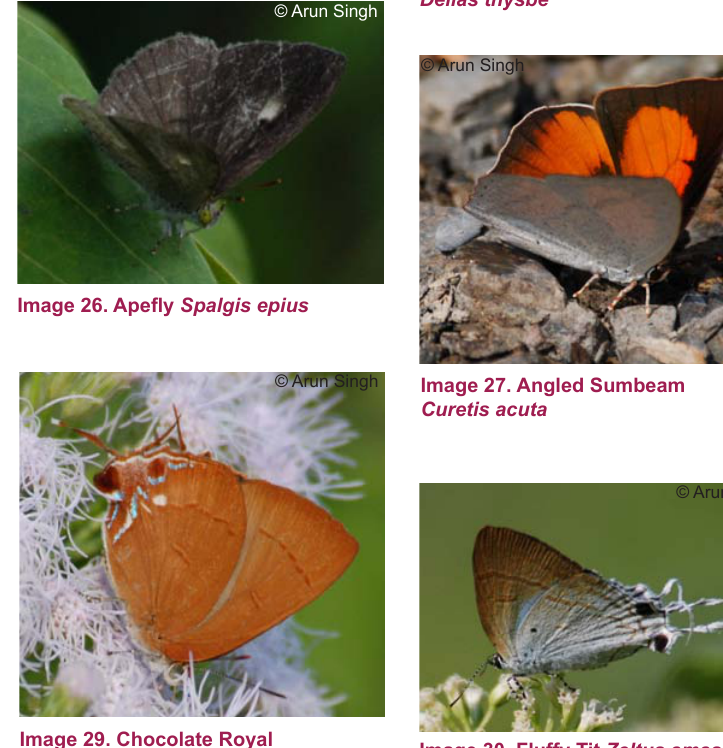
Image 30. Fluffy Tit Zeltus amasa